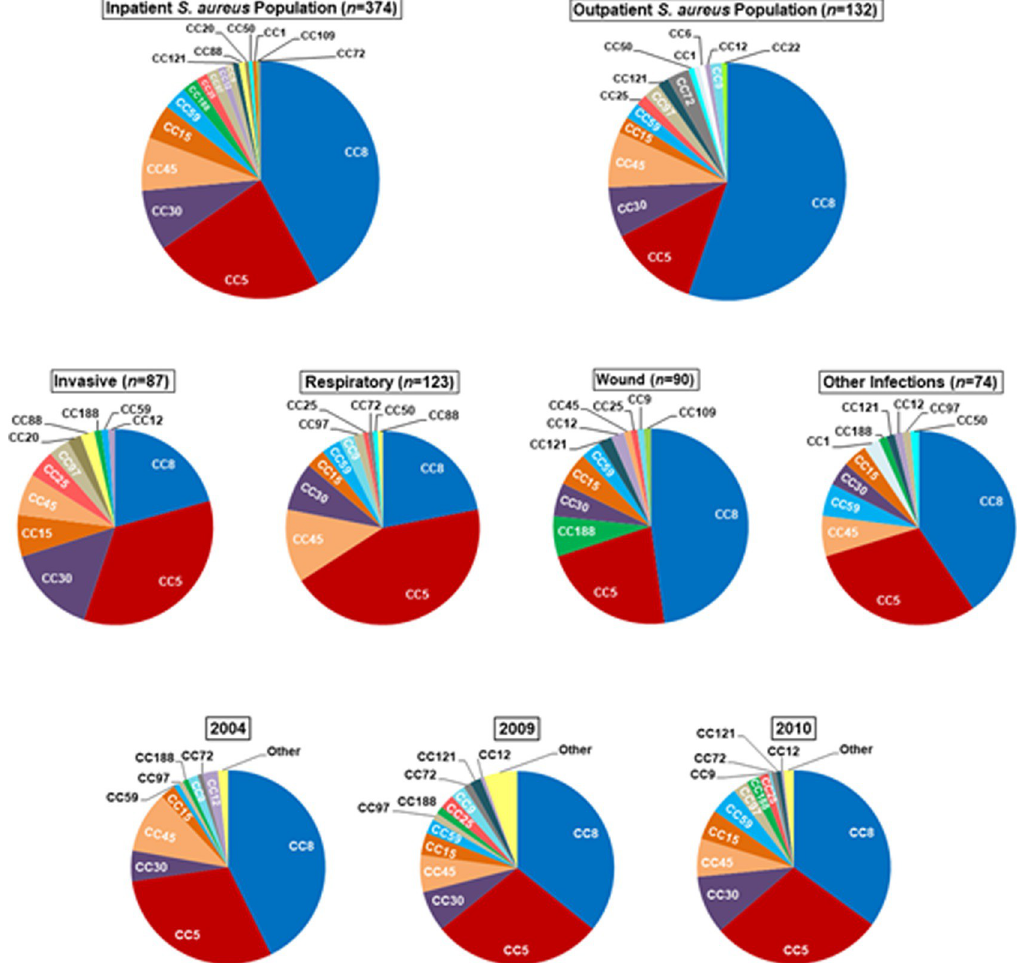
Fig 1. Clonal complex (CC) distribution among disease-causing S . aureus isolates in the US. (A) All isolates associated with S . aureus infections in healthcare and community settings. (B) S . aureus isolates associated with the main types of clinical infections in healthcare settings. (C). Temporal variation in the distribution of CC amongst S . aureus isolates.